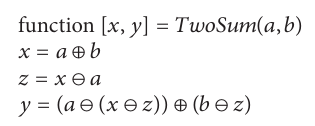
Algorithm 1: Sum of two floating point numbers.